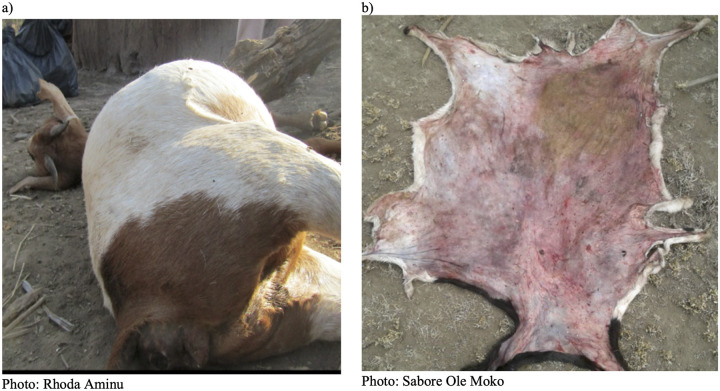
Examples of suspected Bacillus anthracis-infected carcasses sampled as part of a field-based surveillance scheme in northern Tanzania.Blood smears, whole blood, blood swabs and skin were obtainable from a), whereas only skin could be obtained from b).